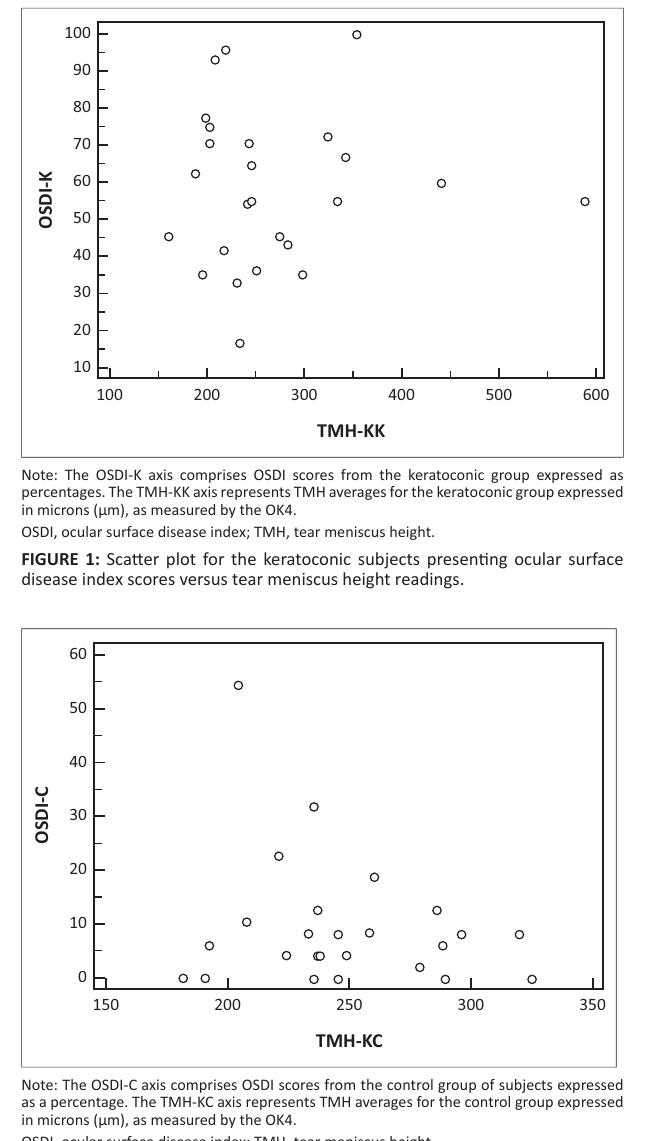
FIGURE 2: Scatter plot for the control subjects presenting ocular surface disease index scores versus tear meniscus